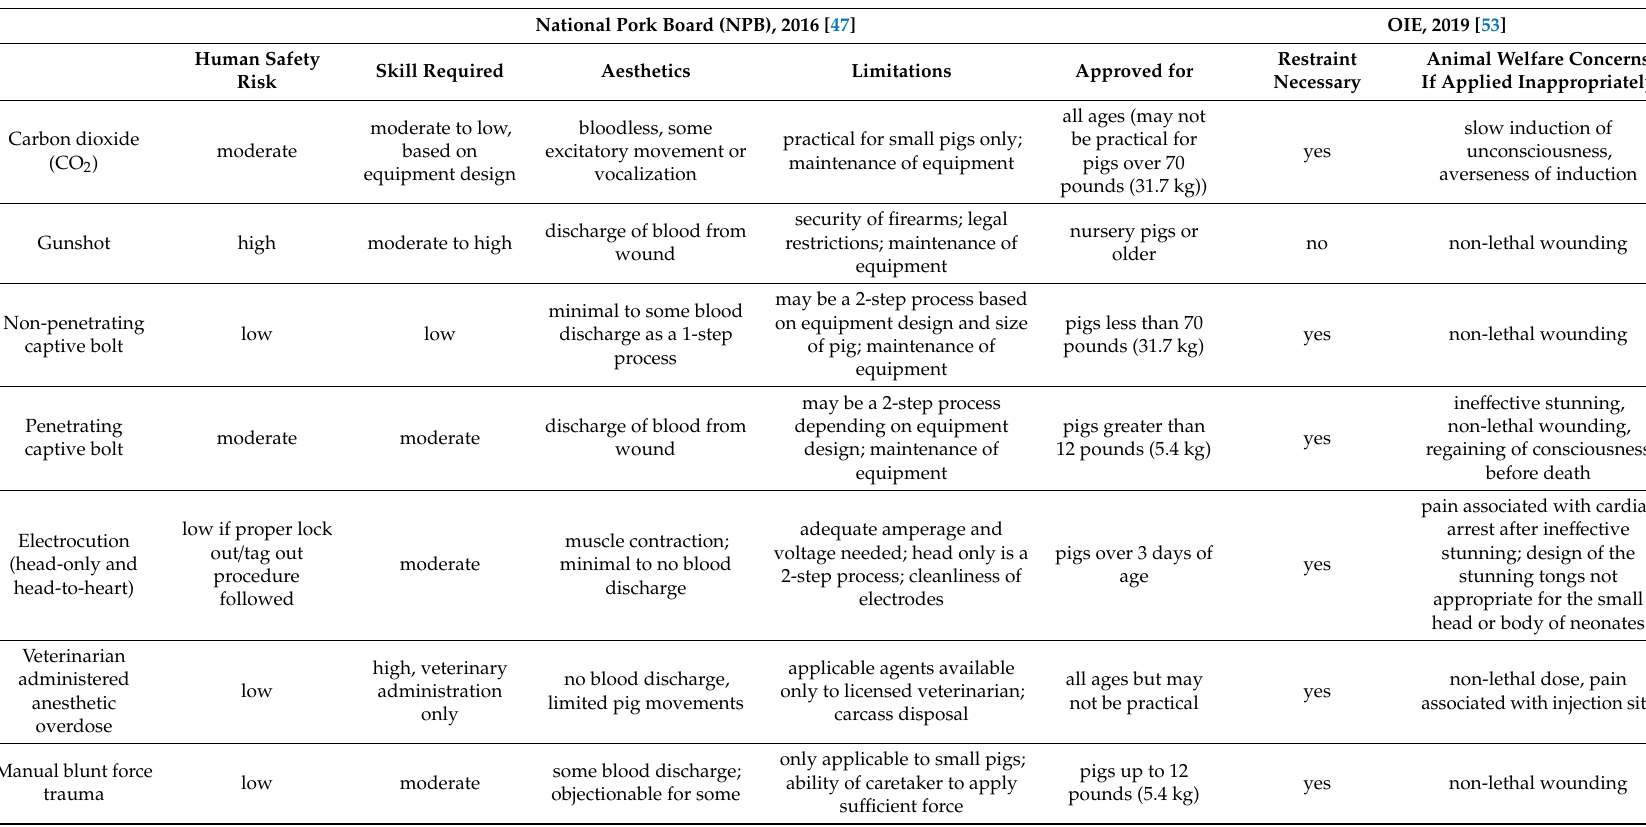
Table 2. Summary of human safety, required personnel skill, aesthetics, and limitations of di ff erent depopulation methods for swine (adopted from the National Pork Board’s guidelines “On-Farm Euthanasia of Swine Recommendations for the Producer” and from OIE guidelines for ‘’Killing of animals for disease control